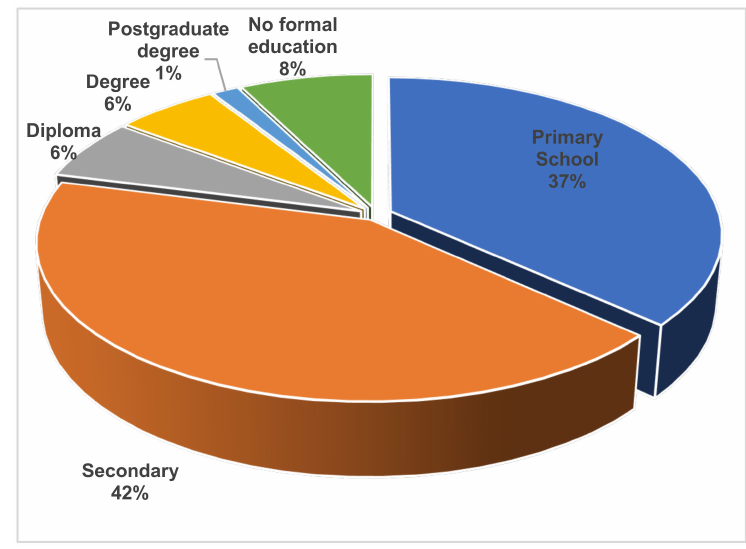
Figure 2. Educational attainment of participants in Ondo State, Nigeria ( n =